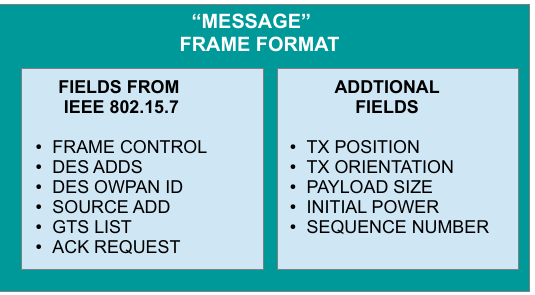
Figure 11. “Message” structure of the frame format in the